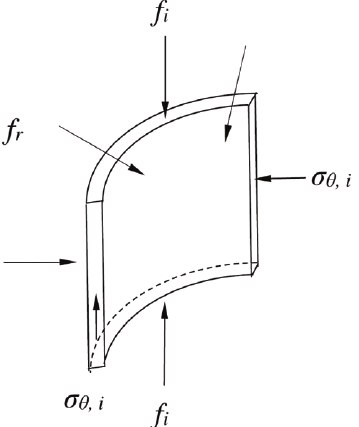
Fig. 3(b). Free body diagram of the inner tube